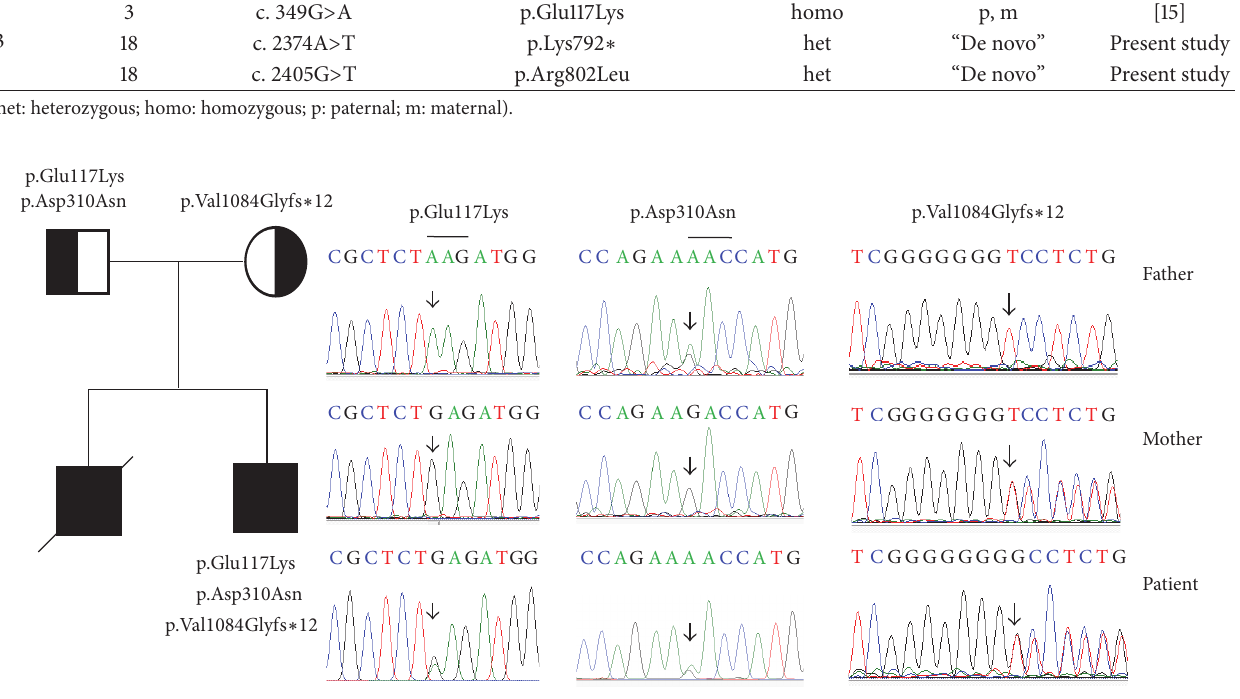
Figure 1: Mutations of the NPHS1 gene were identified by sequencing in patient 1 and his parents. The pedigree and mutations of the NPHS1 gene were identified in the family of patient 1, including a heterozygous variant p.Glu117Lys, a mutation p.Asp310Asn, and a heterozygous frameshift mutation p.Val1084Glyfs ∗